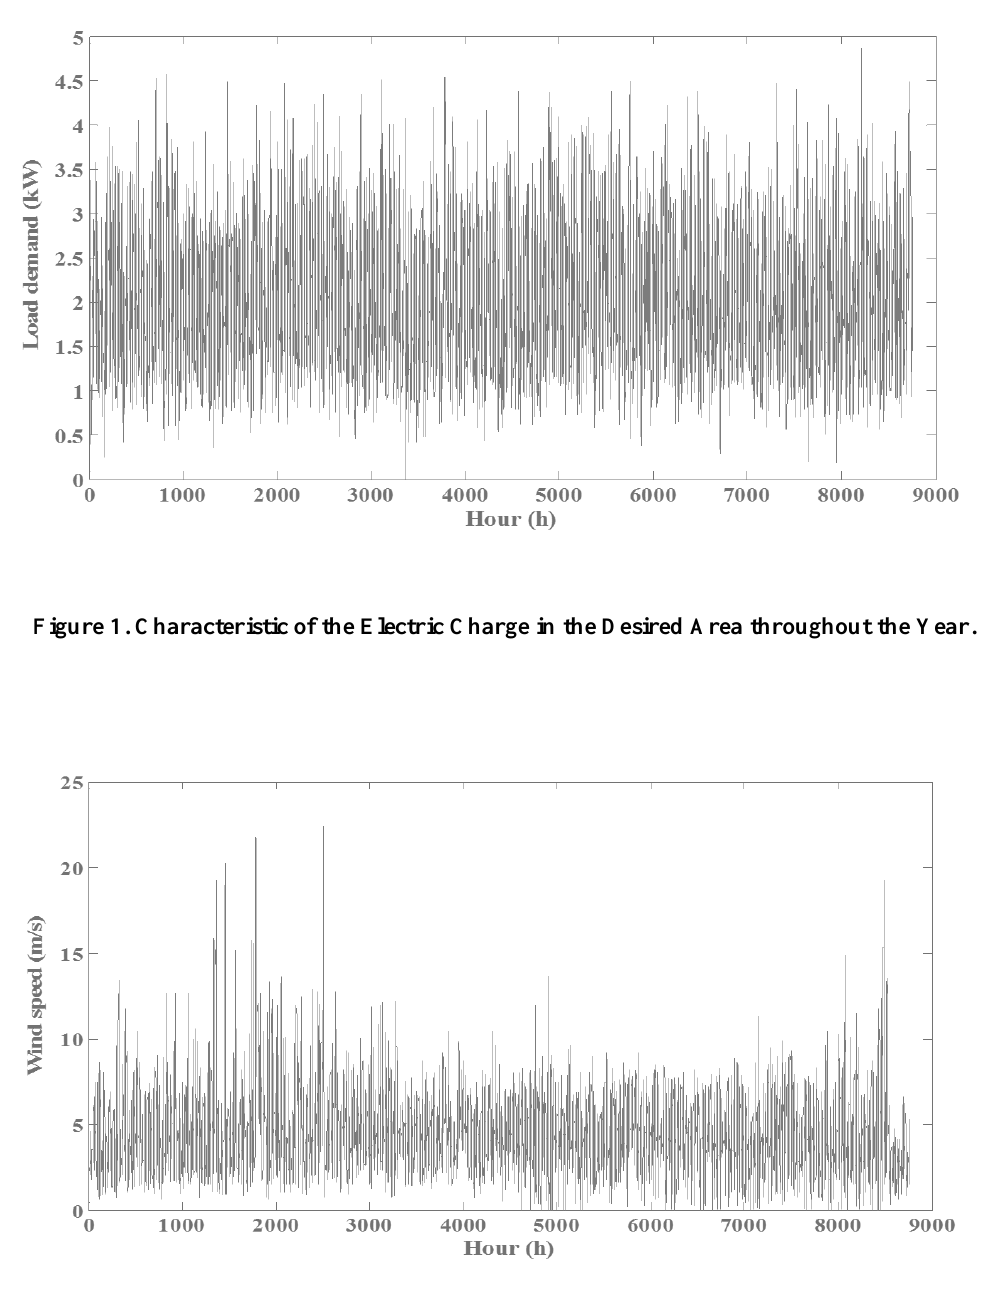
Figure 2. The Shape of the Wind Speed in the Area Desired during the Year (Height 10